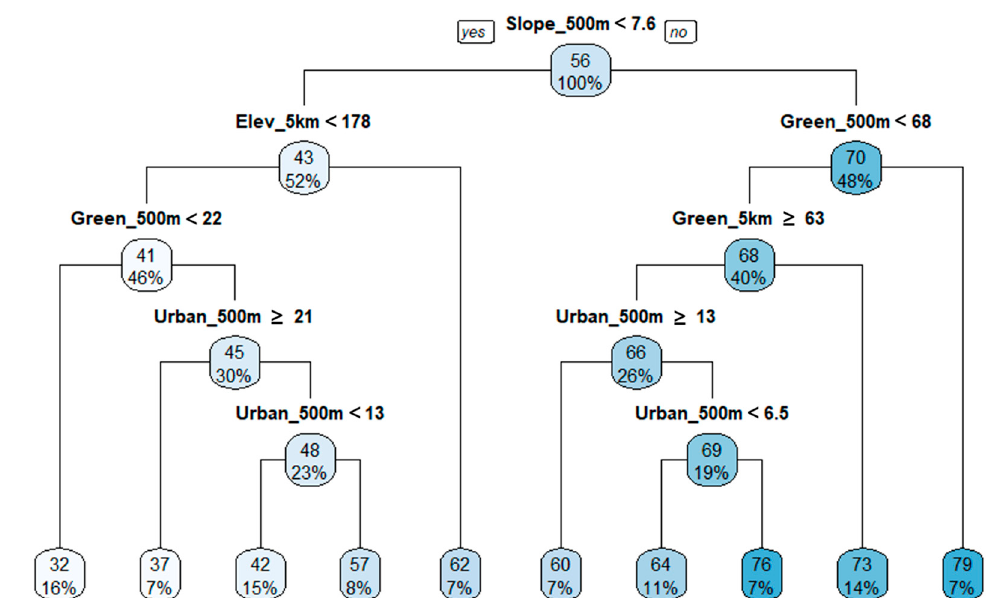
Figure 5. Regression tree for TDI with stream topographical variables and proportions of green and urban areas in buffer areas (R 2 = 0.67). The numbers located on top in color boxes are mean values of TDI.